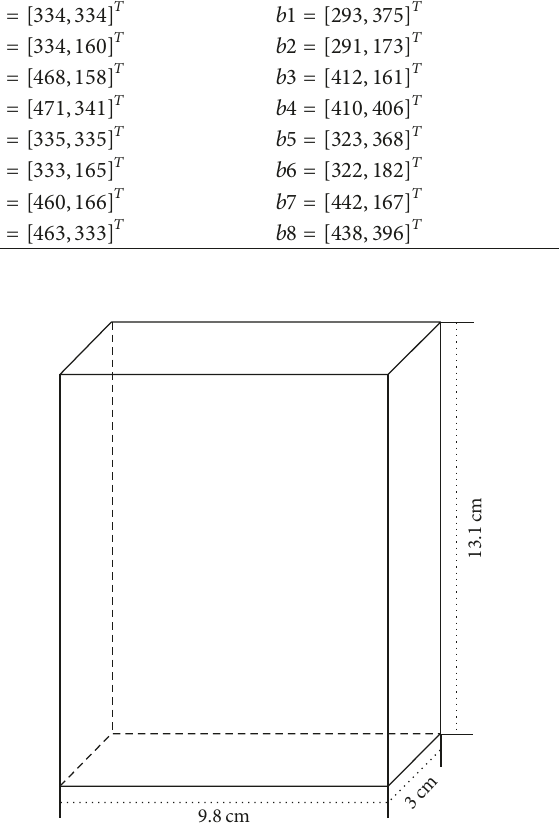
Figure 3: Dimensions of the transparent